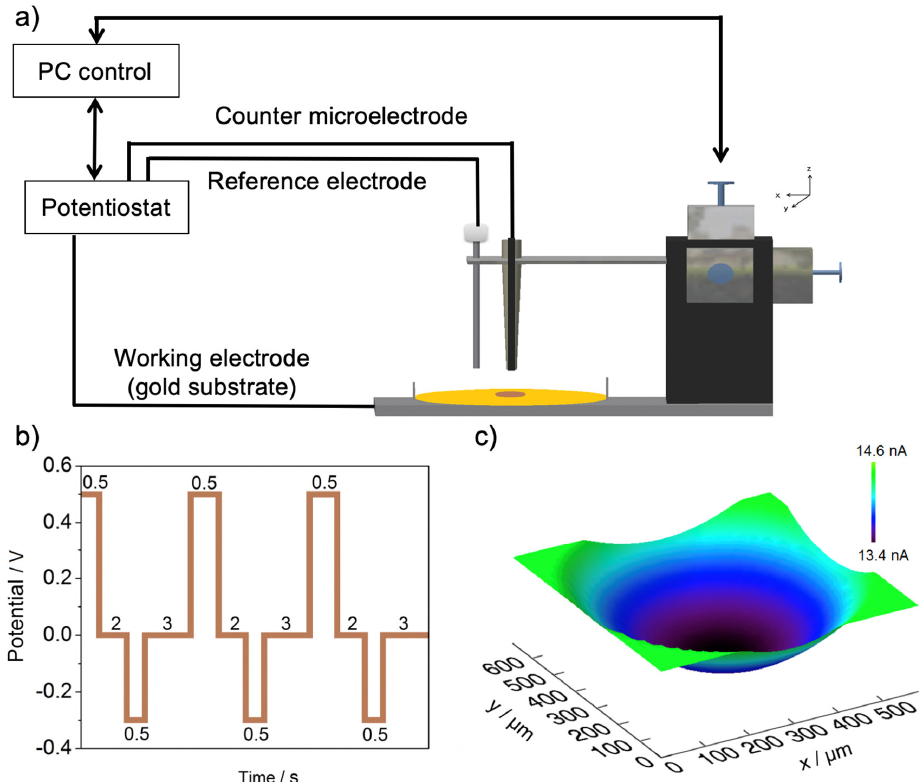
Figure 1. ( a ) Scheme of the SECM direct mode approach for micro-structured PDA deposition. ( b ) Potential pulse profile for electropolymerization. ( c ) 3D SECM image of PDA microspot deposited with 30 cycles. The image is obtained in 5 mM ferrocenedimethanol/0.1 M KCl with a Pt UME (12.5 µm radius); scan velocity 10 µm/s.